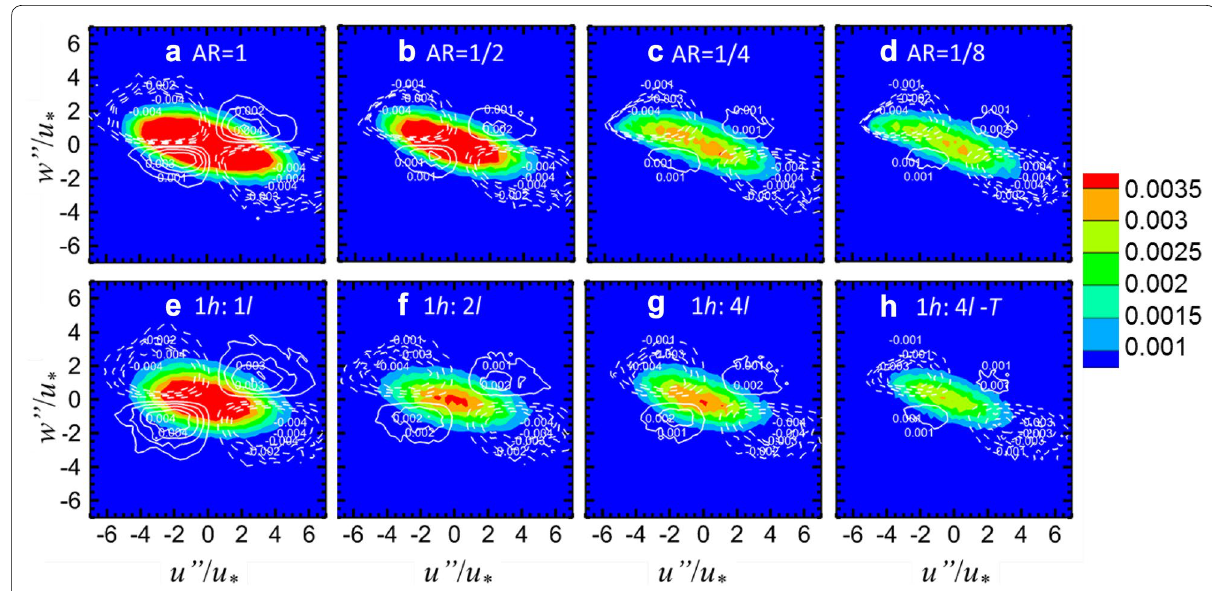
Fig. 7 Shaded contours of joint probability density function (JPDF) P ( u ″ , w ″ ) and line contours of covariance integrand u ″ w ″ P ( u ″ , w ″ ) at canopy height ( z h ) of P4 measured over the rib‑type arrays of a AR = 1h:4l, and h 1h:4l‑T